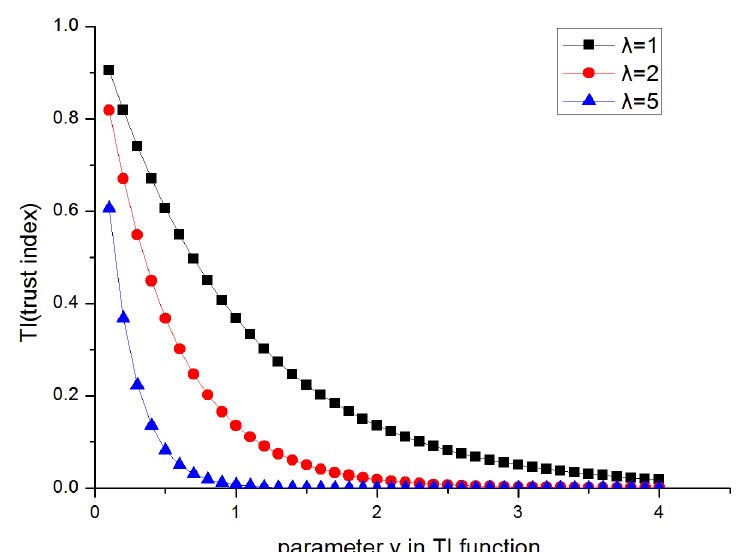
Figure 2. The family curves of